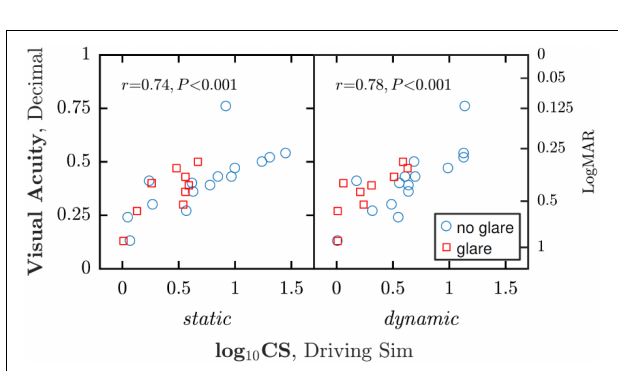
FIGURE 3 | Correlations between CS (measured within the simulator) and low contrast VA (measured outside the simulator). Note that each participant contributed two data points to each analysis, and as such a more statistically correct approach would have been to use a linear mixed effects model to account for any dependencies between within-subject data